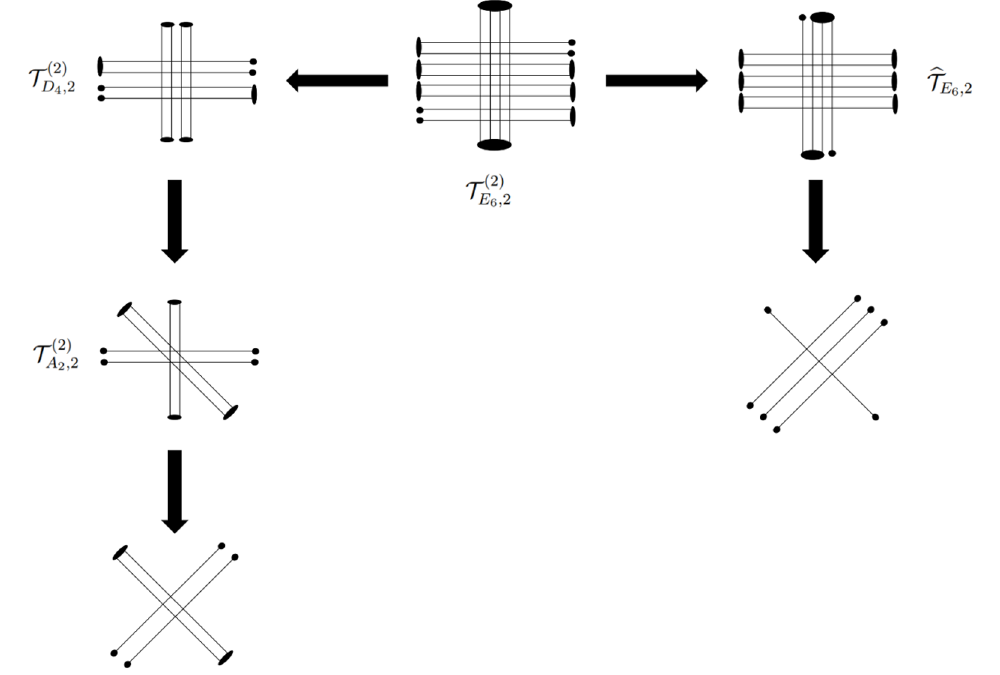
Figure 9. An illustration of the mass deformations for the case of T (2) represented through their brane webs, whose twisted compacti(cid:12)cation yields the 4 d T (2) of its mass deformations. Here the compacti(cid:12)cation is done with a Z 2 twist corresponding to a (cid:25) rotation of the web and the SL(2 ; Z ) transformation (cid:0) I . Next to each web is written the 4